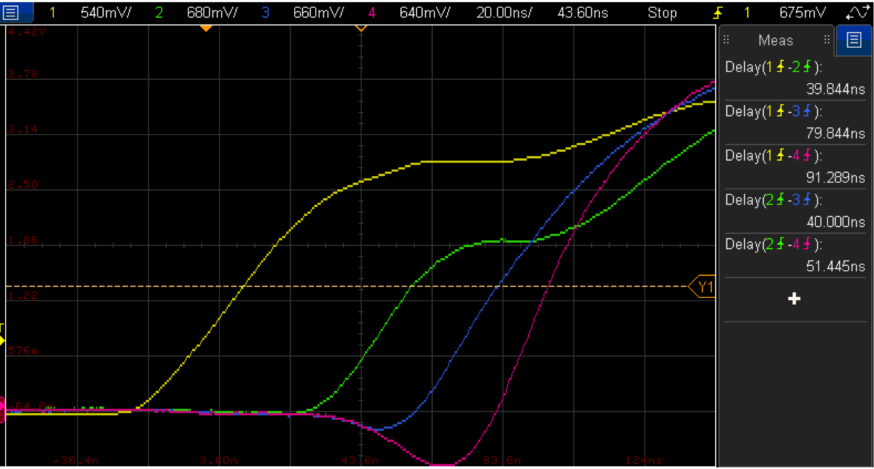
Figure 4. Global sync clock (yellow) and sampling clocks on the accelerometer side with 1 m (green), 5 m (blue) and 10 m (red) cable.